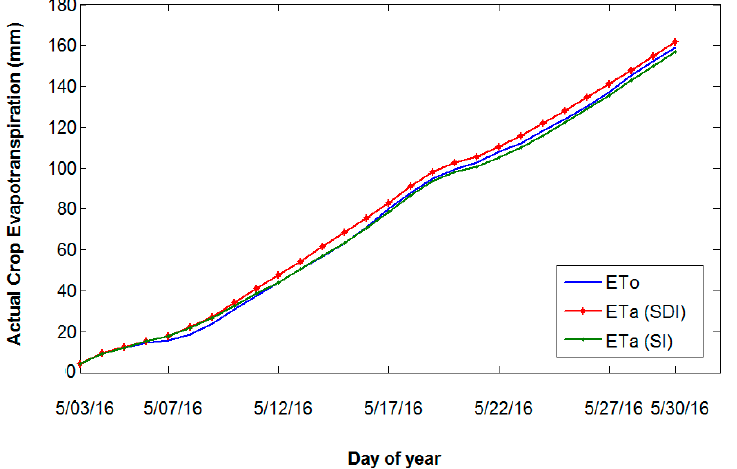
Figure 3. Actual alfalfa evapotranspiration (ETa) during an individual cutting cycle for surface irrigation (SI) and sub-surface drip irrigation (SDI) obtained with the residual of energy balance (REB) method through commercial surface renewal (SR) equipment in 2016 at the UC Davis experiment.